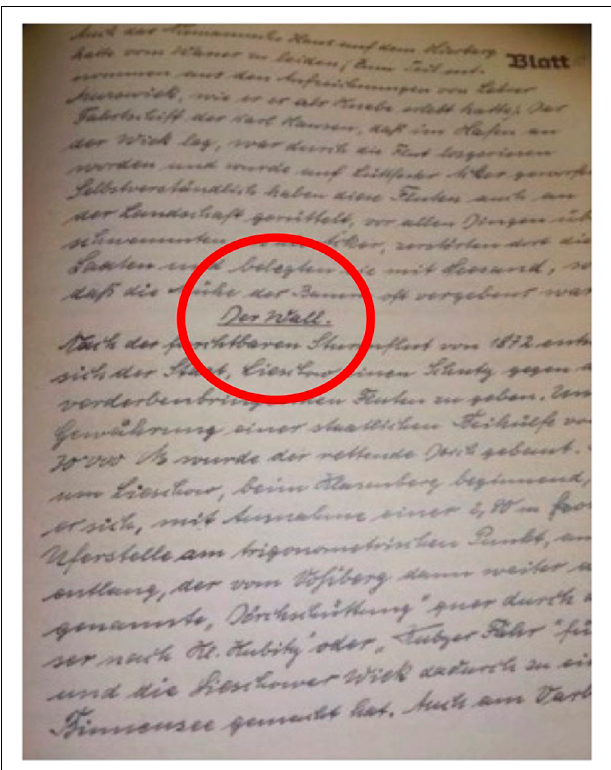
FIGURE 1 | Page from the village chronicle reporting about the construction of the ring dike (“Der Wall”–highlighted in red color). Source: Collection, Rita Hoff, annalist of